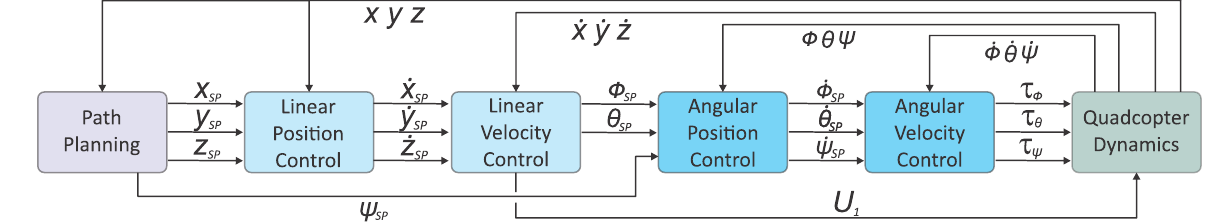
Figure 2. Information flow of the cascade controller.